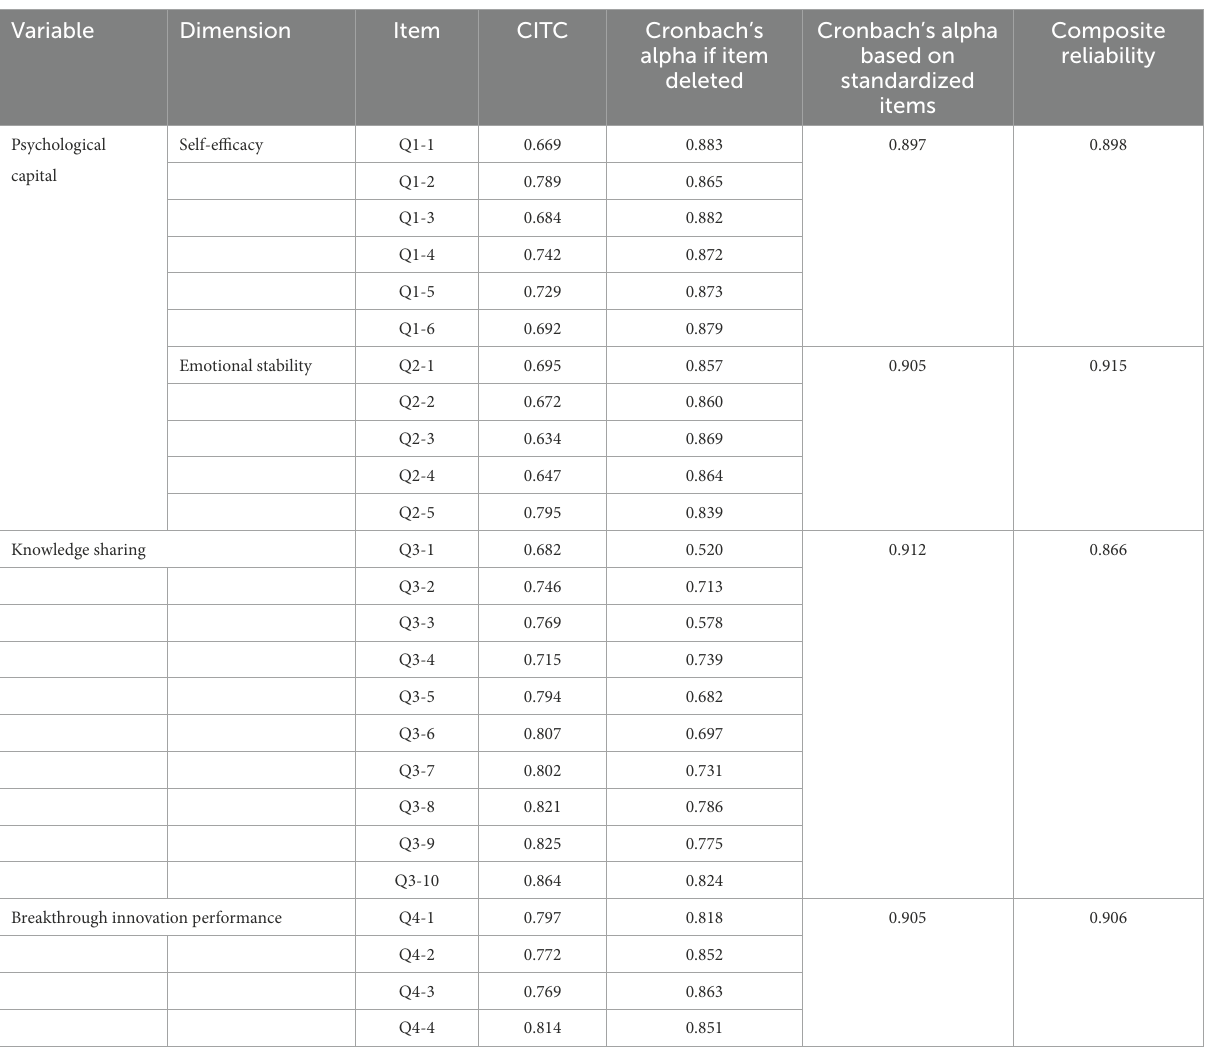
TABLE 3 Reliability analysis table of the questionnaire. Variable